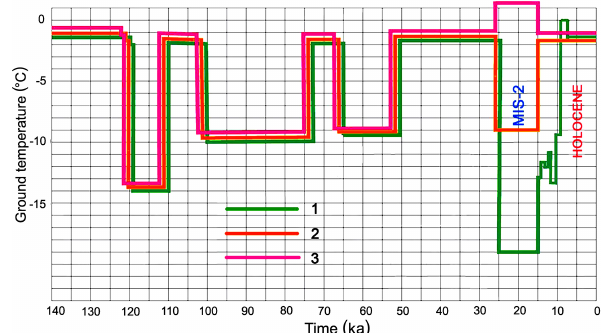
Figure 6. Paleotemperature curves for 50m isobath: 1 – periglacial subaerial northeastern shelf part (NE); 2 – ice that reached the bot- tom from 7 to 10ka (G-1); 3 – subaqual (beneath dam lake) central shelf part